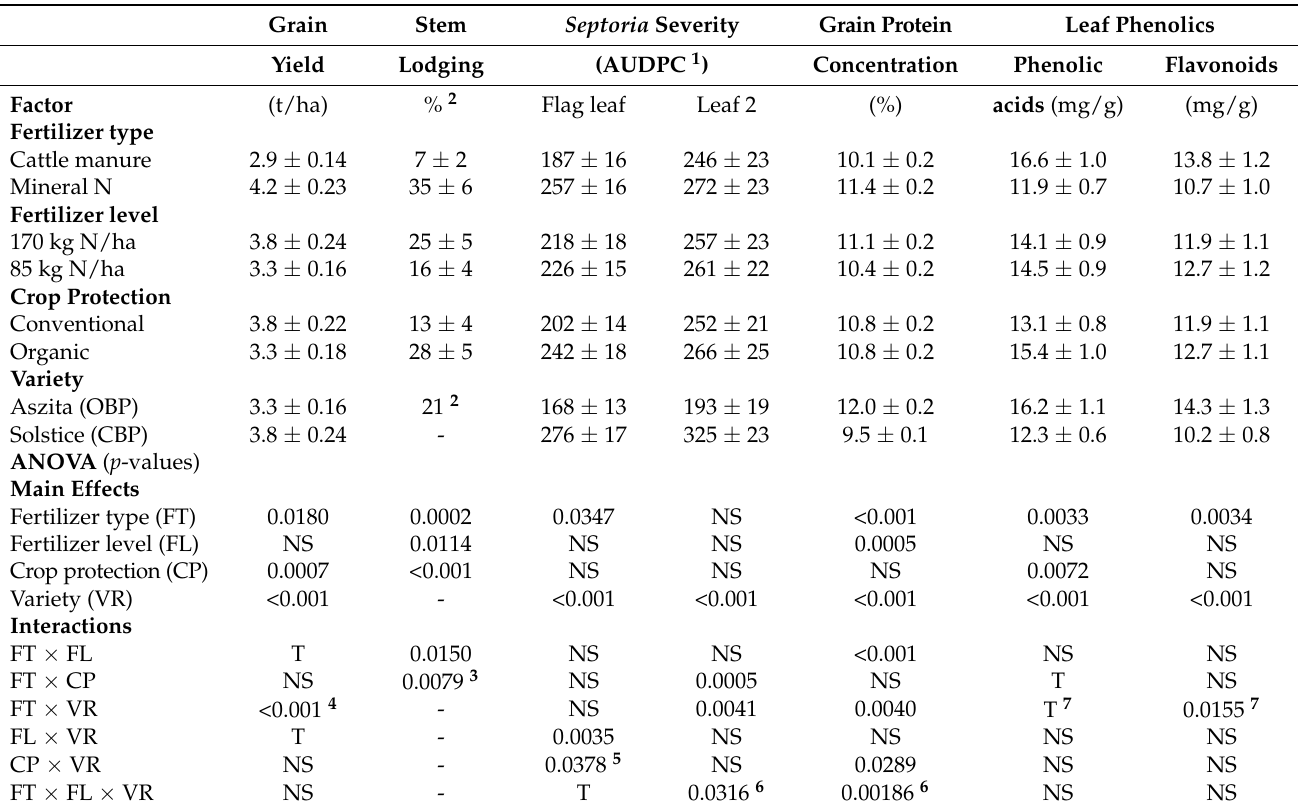
Table 1. Main effect means ± SE and ANOVA results ( p -values) for the effects of fertilizer type, fertilizer input level, and crop protection and variety on grain yield, stem lodging, Septoria severity, grain protein concentration and leaf phenolic concentrations in winter wheat ( T. aestivum ) in field trials carried out at Nafferton Farm, Northumberland, UK. Results shown are from a re-analysis of previously published data from two growing seasons (October 2009; November 2010) [6].